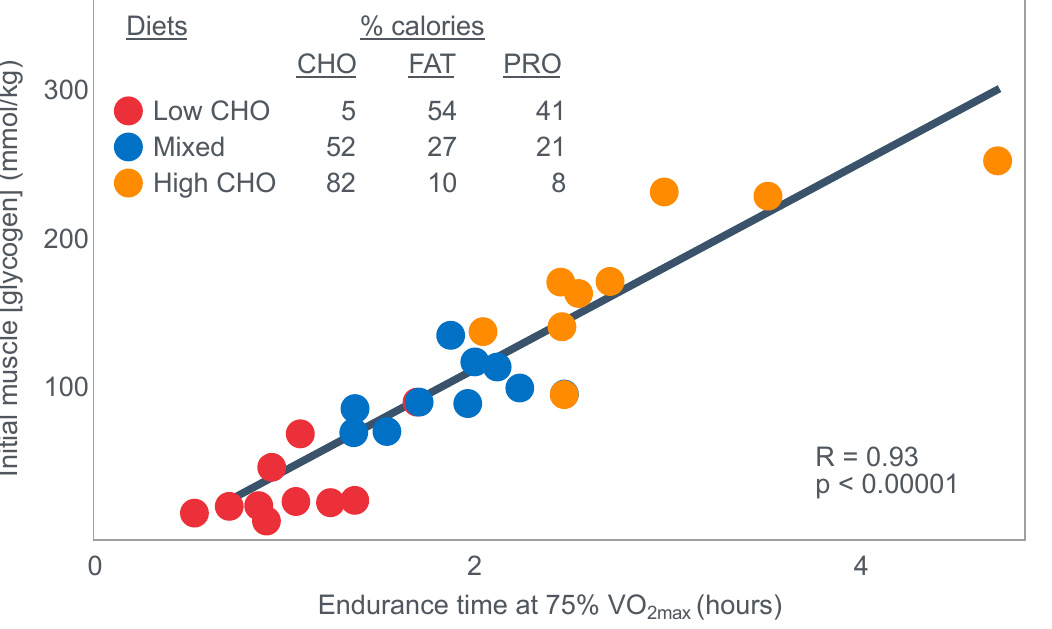
Figure 5. Relationship between initial muscle glycogen concentrations and exercise duration at 75%VO2max in subjects acutely adapted to high-, mixed- and low-carbohydrate diets. Adapted with permission from ref. [17]. Copy-right 1967 Acta Physiologica (John Wiley and Sons).